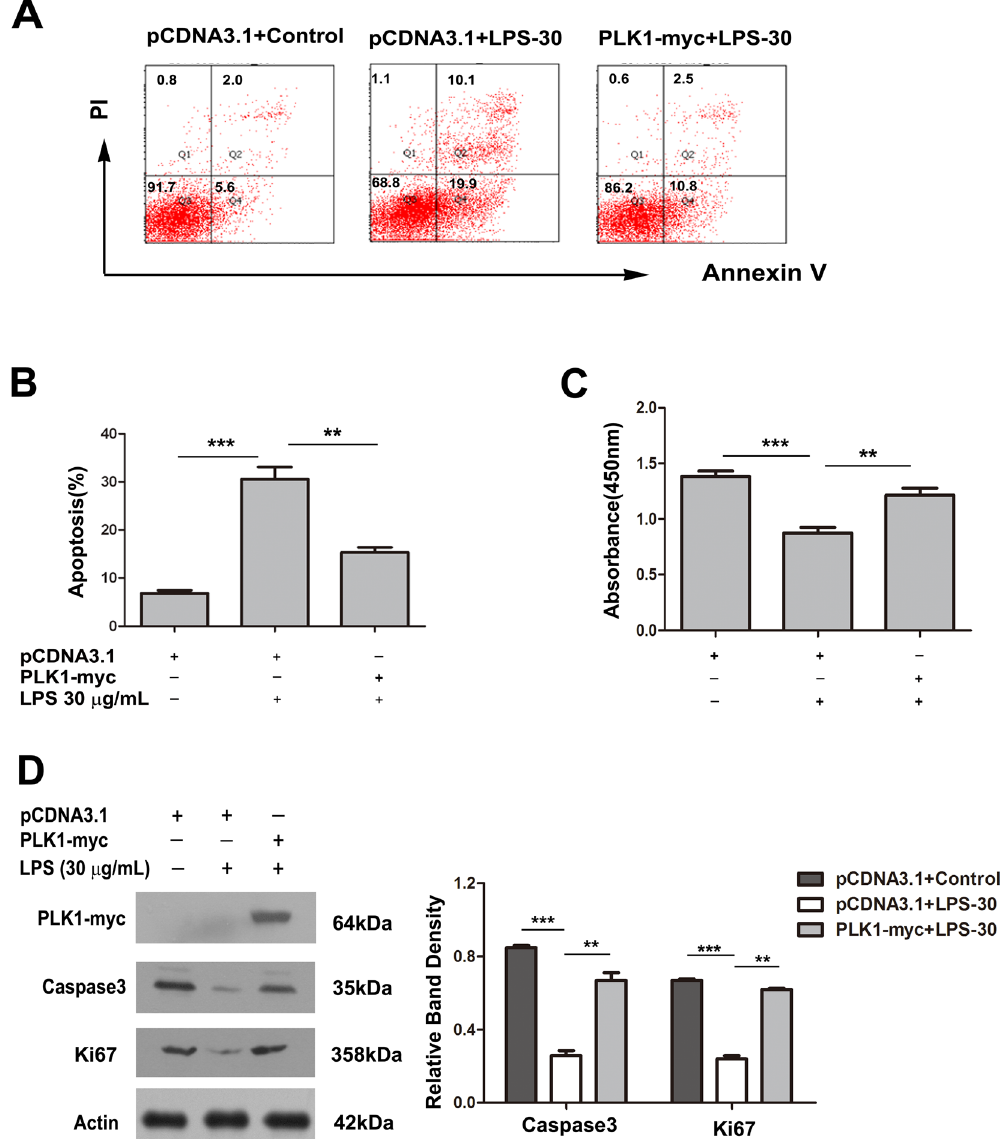
Figure 6. Over-expression of PLK1 partly rescues the apoptosis and proliferation inhibition caused by LPS in HT29 cells HT29 cells were transfected with pcDNA-PLK1-myc or the control cDNA for 24 h, then exposed to LPS (30 μ g/ml) for 24 h. ( A ) A representative result of apoptosis analysed by Annexin V-FITC/PI double- labelling assay in HT29 cells after the above treatments. ( B ) Percentages of apoptotic cells in HT29 cells after the above treatments. Values are mean ± SEM (n = 3). ** P < 0.01, *** P < 0.001. ( C ) The absorbance at 450 nm of HT29 cells after the above treatments. Values are mean ± SEM (n = 3). ** P < 0.01, *** P < 0.001. ( D ) The levels of Ki67 and caspase3 after the above treatments. The graph represents the relative band densities. Values are mean ± SEM (n = 3). *** P < 0.001 versus control group. ** P < 0.01 versus LPS